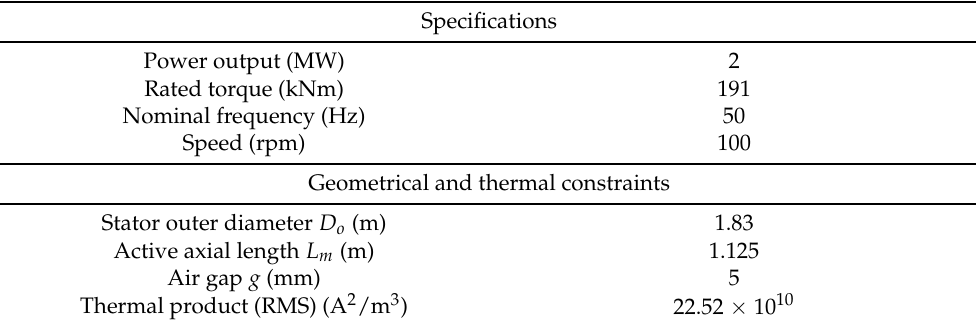
Table 1. TDSPM design specifications and constraints